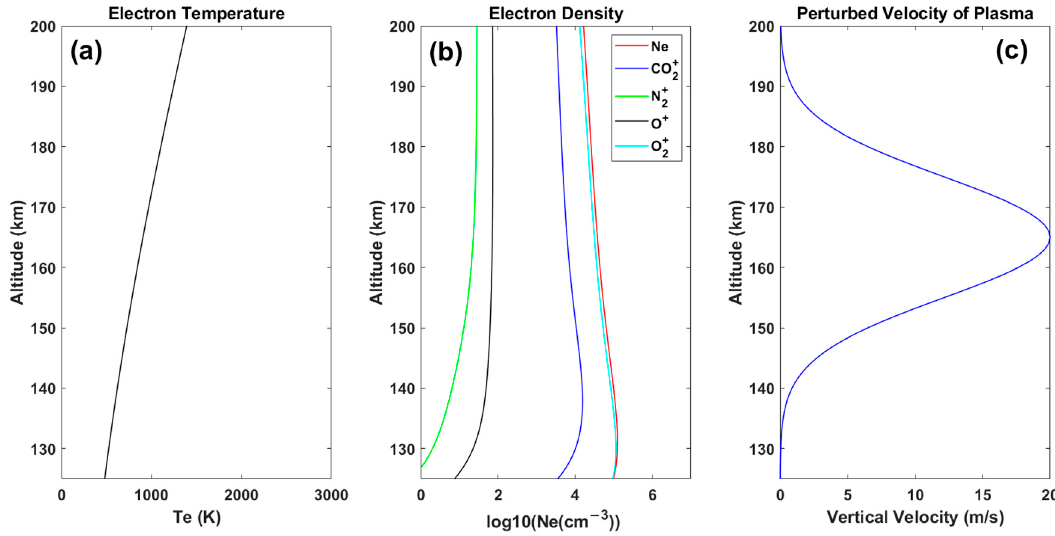
Figure 4. Initial parameters for the model in this study. ( a ) electron temperature; ( b ) densities of O 2+ , CO 2+ , O + , and N 2+ electrons; ( c ) disturbed vertical upward velocity of plasma. Table 2. Run modes of the simulation with different